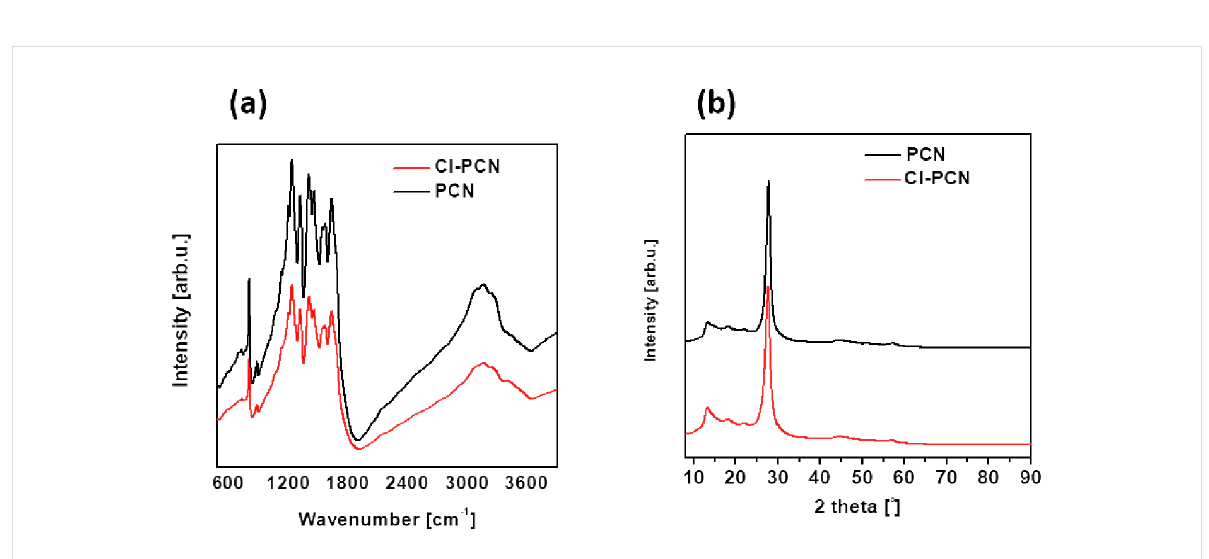
Figure 2: AFM images and height profile of PCN (a, b) and Cl-PCN (c, d).